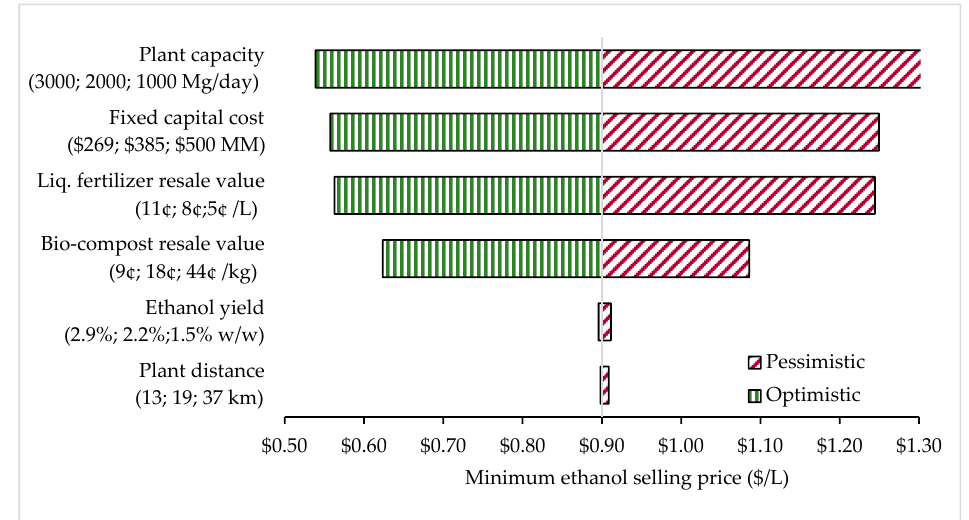
Figure 9. Sensitivity analysis for the scenario C FW fermentation process, without enzymes and a 1-step distillation system. Optimistic is the best-case scenario simulation and pessimistic is the worst-case scenario simulation.